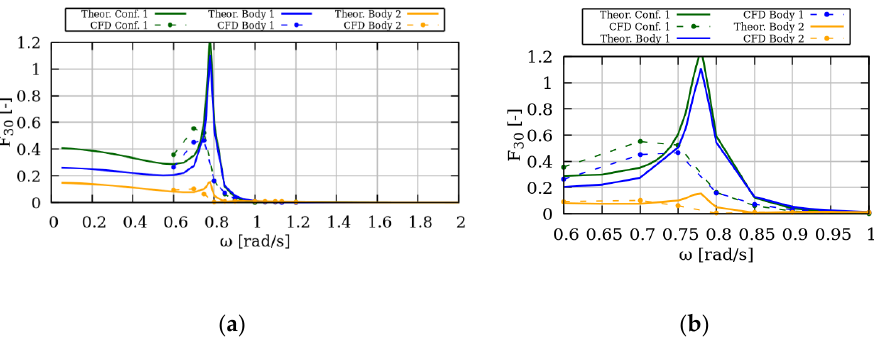
Figure 10. Comparison between the theoretical and CFD results of the non-dimensional vertical excitation force, in case of the Configuration 1; ( a ) wave frequencies 0.05 and 2 rad/s; ( b ) wave frequencies between 0.6 and 1.0 rad/s (detailed view).